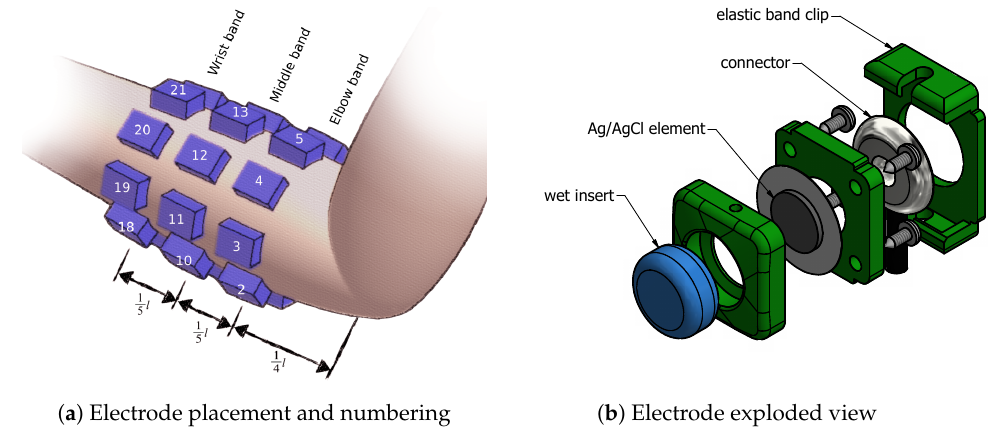
Figure 2. Schematics of electrode placement on the subject’s forearm during the experiment, and design of the reusable wet electrode setup used for the putEMG dataset experiment.